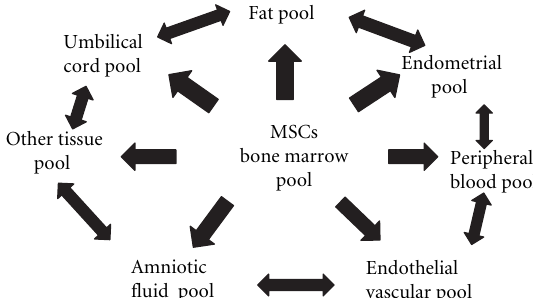
Figure 3: Mesenchymal stem cells pools as a coordinated